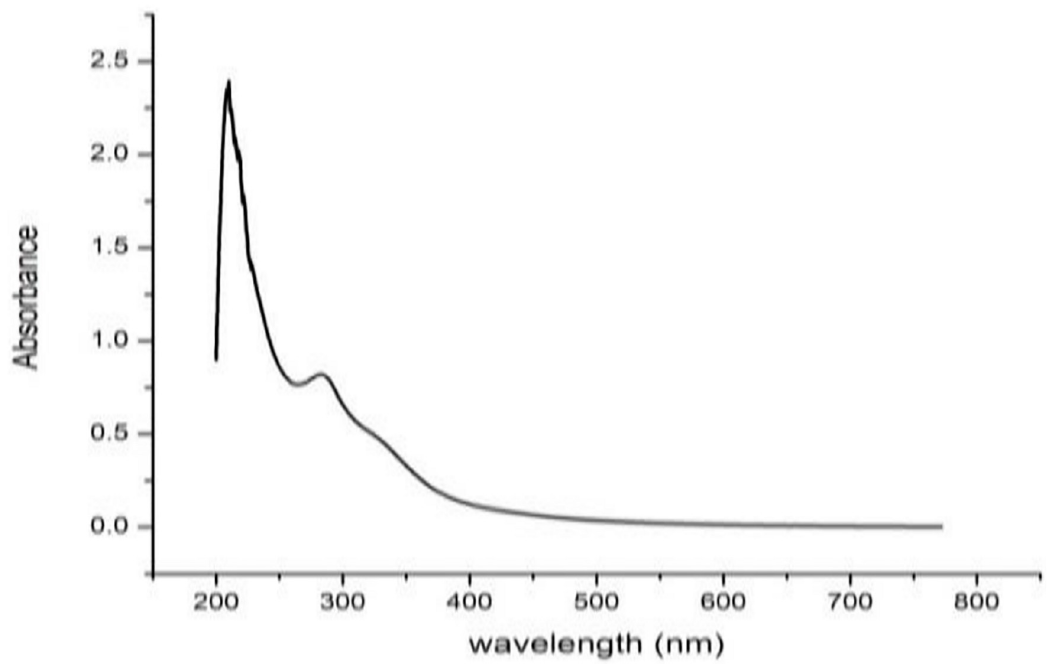
Fig 5. UV-Vis spectrum of ethanolic extract of M . piperita